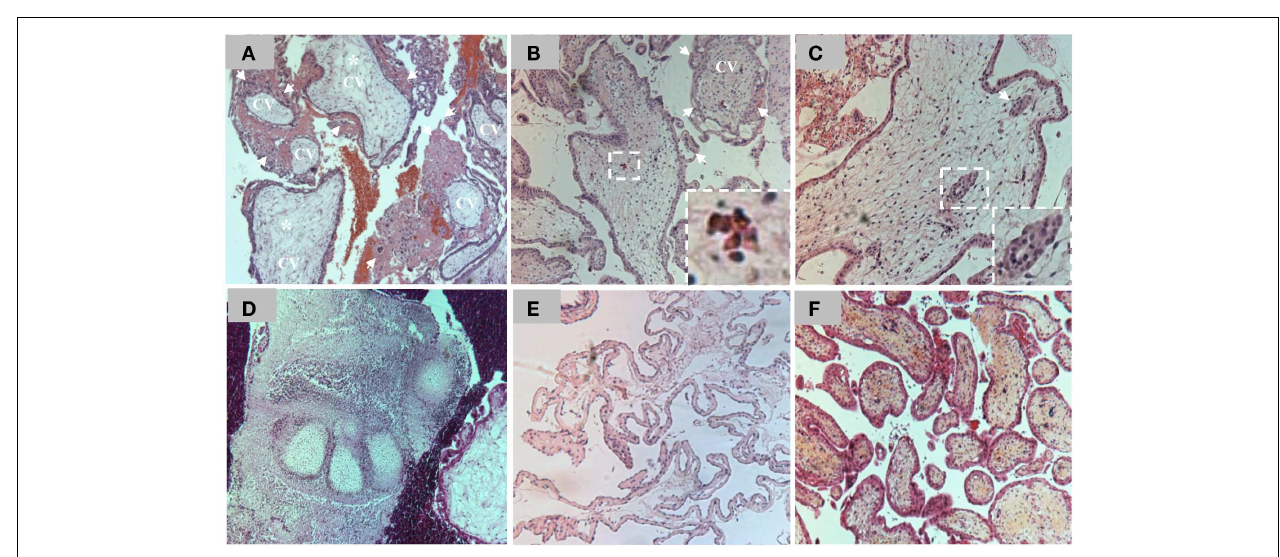
(arrows). Note the presence of nucleated red blood cells inside the chorionic villus (on the right corner) in the conception that led to PHM. (C) One CV from a PHM displaying trophoblastic inclusions (arrows and magnified view on the right corner). (D) A view from a PHM showing phalanges of fetal foot. (E) Another view from a PHM showing fetal membranes. (F) H&E staining of a section of CV from a spontaneous abortion. Note the absence of trophoblastic proliferation around the